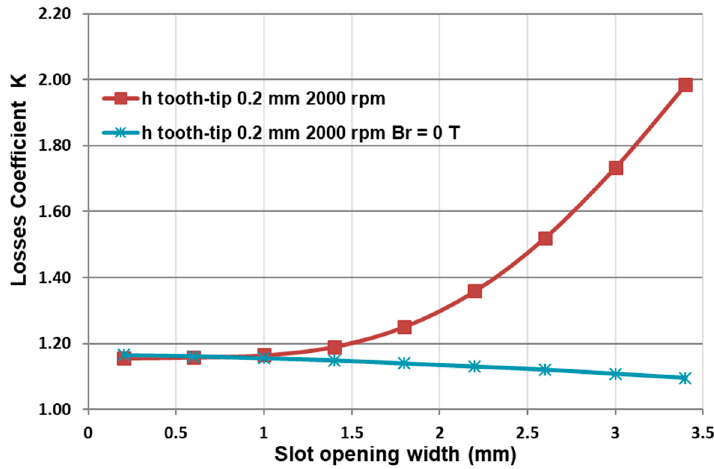
Figure 32. Slot opening width effect on Losses Coefficient K .